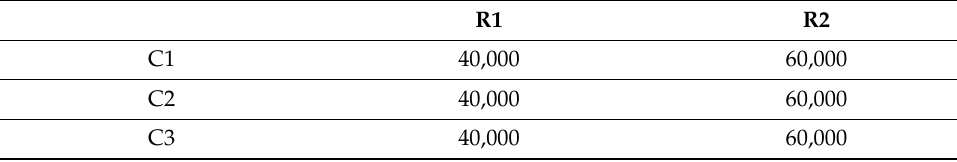
Table A3. Distribution center storage capacity (tons/period).